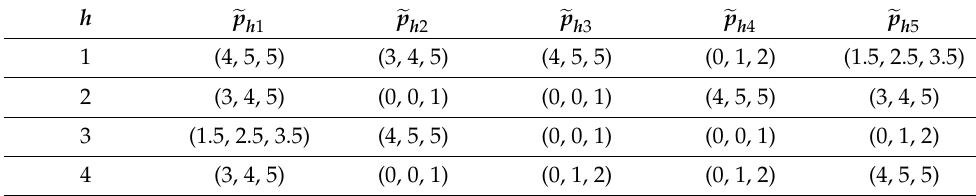
Table 4. Performances of the leisure agricultural parks.